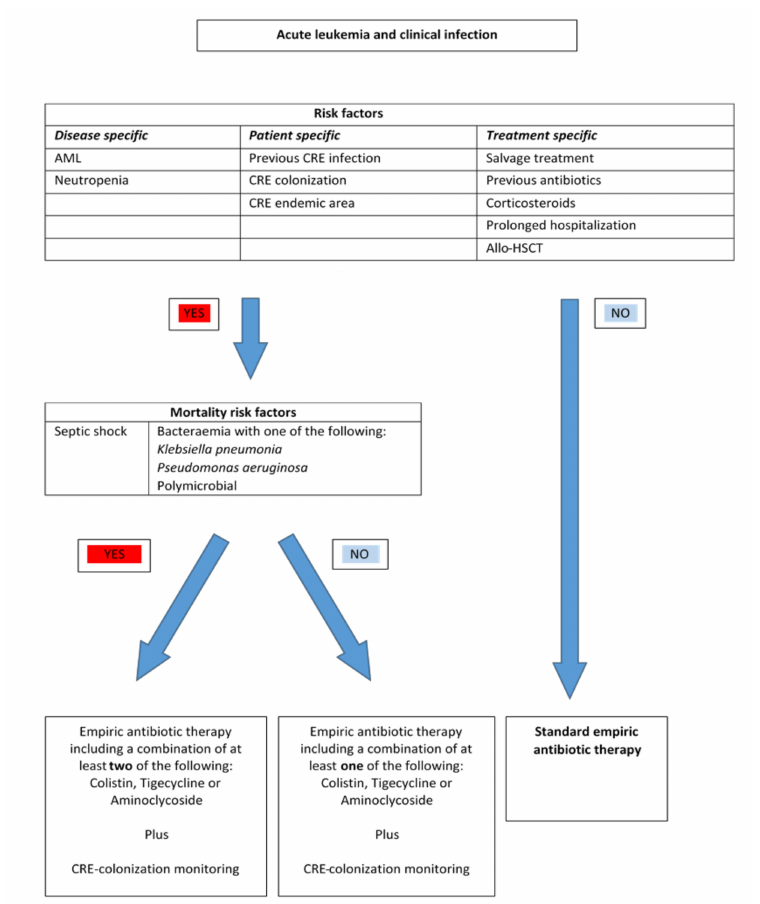
Figure 1. An algorithm of risk assessment and empirical management of febrile patients with hematological malignancies (HM). Based on Lalaoui